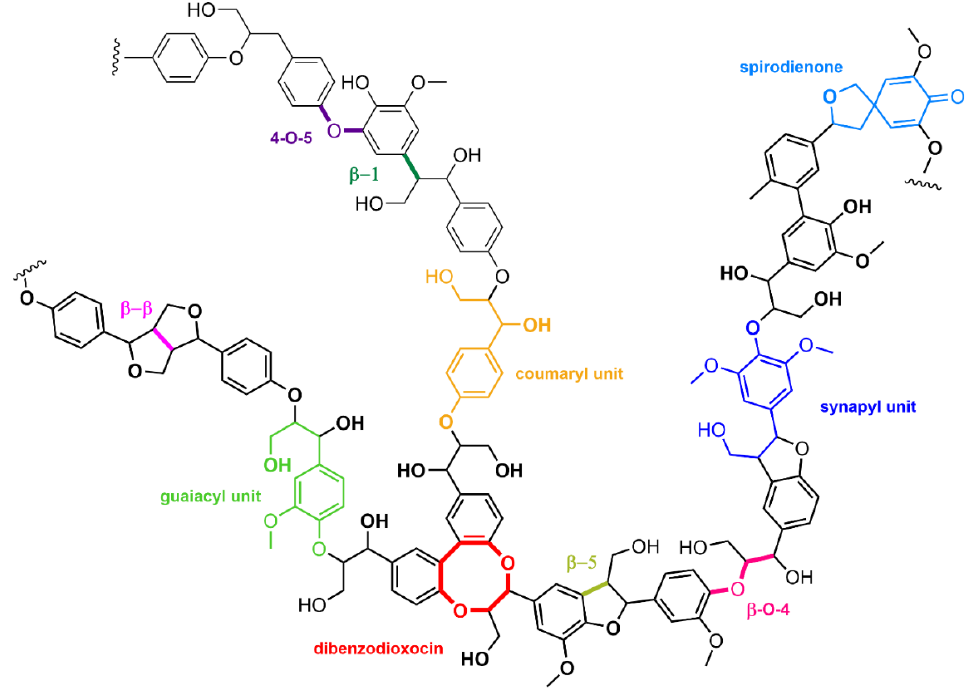
Figure 4. Example of lignin structure highlighting the diversity of constituting units and interunit bonds.